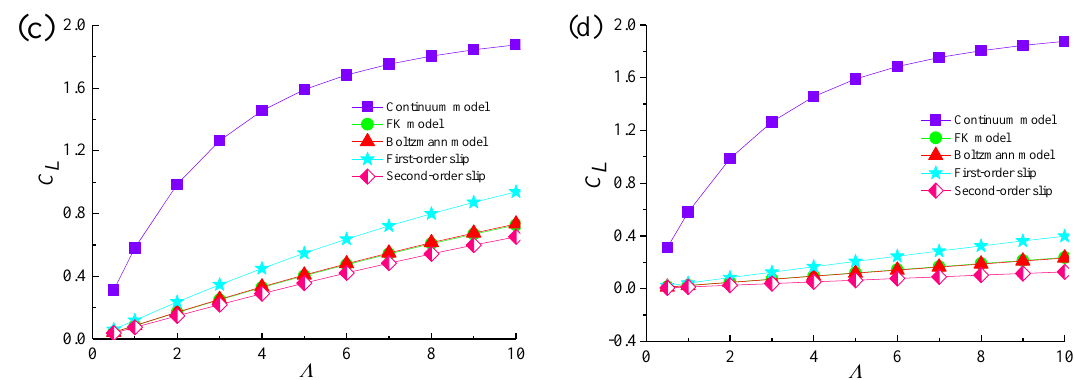
Figure 6. Relationship between the dimensionless load capacity and the bearing number for different gas rarefaction models ( ε = 0.6, B / D = 1.4). ( a ) K n = 0.0054; ( b ) K n = 0.0325; ( c ) K n = 0.65; ( d ) K n = 2.1667.